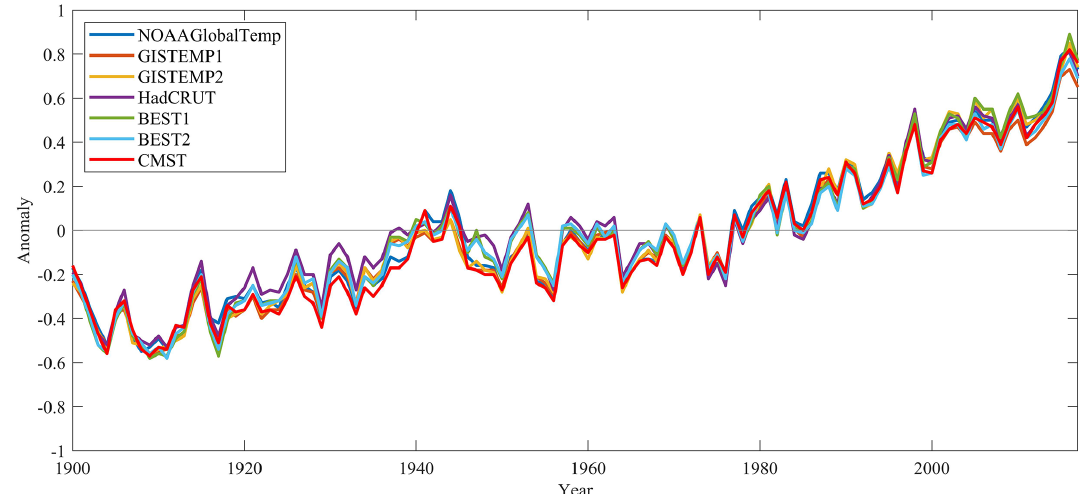
Figure 8. Comparison of global mean ST anomalies series during 1900–2017 for different datasets (relative to